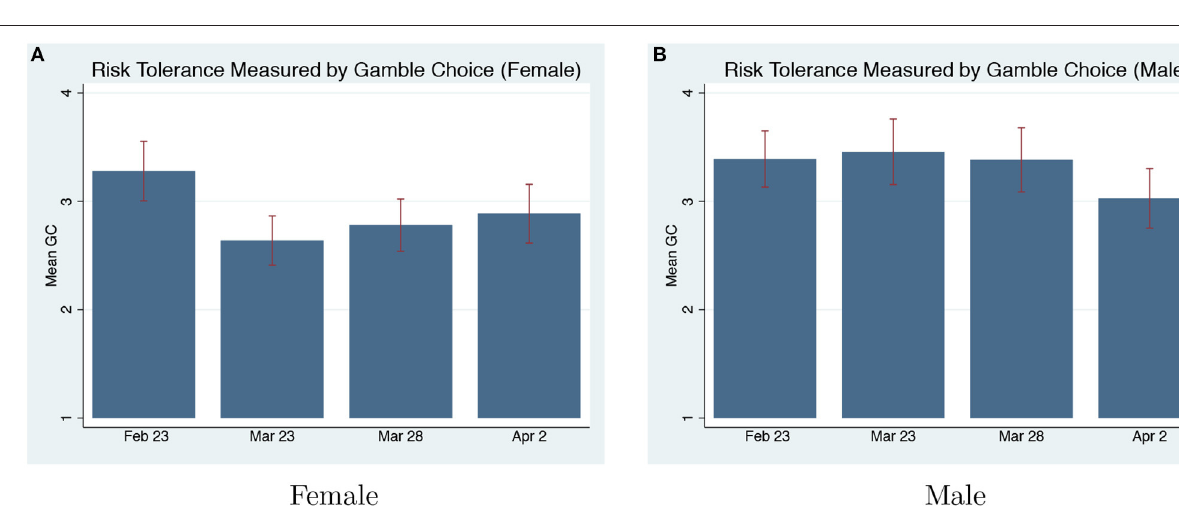
FIGURE 2 | Gender differences in risk-taking by BART pre and on-pandemic.